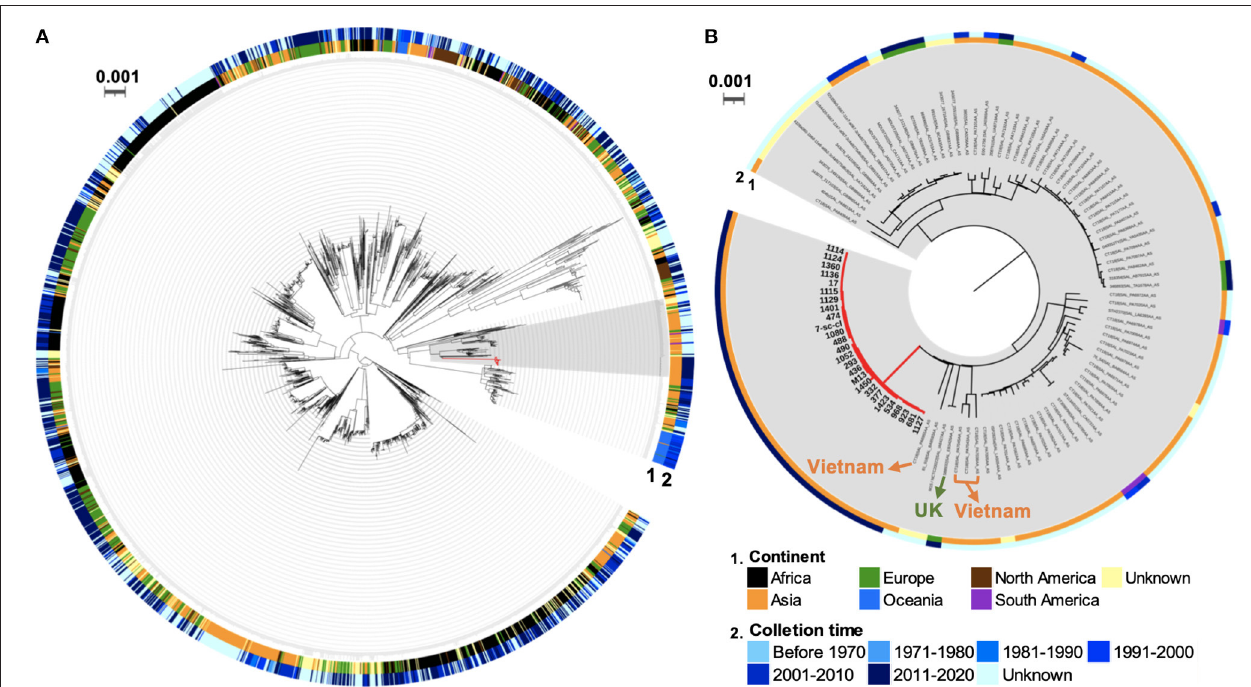
FIGURE 4 | Global phylogenetic tree of S. Typhi ST2 isolates. (A) Phylogenetic relatedness of global S. Typhi ST2 isolates. (B) A subtree of global isolates with close relatedness to the outbreak isolates. The branches in red indicate the outbreak isolates in this study. Two rings represent the geographical origin (continent) and collection time of these